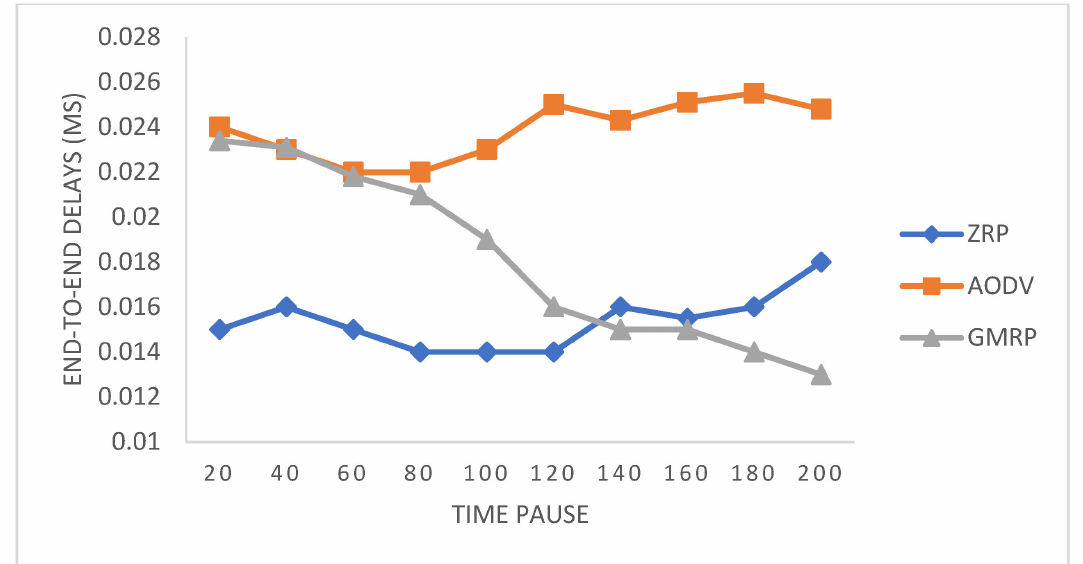
Figure 16. End-to-end delays